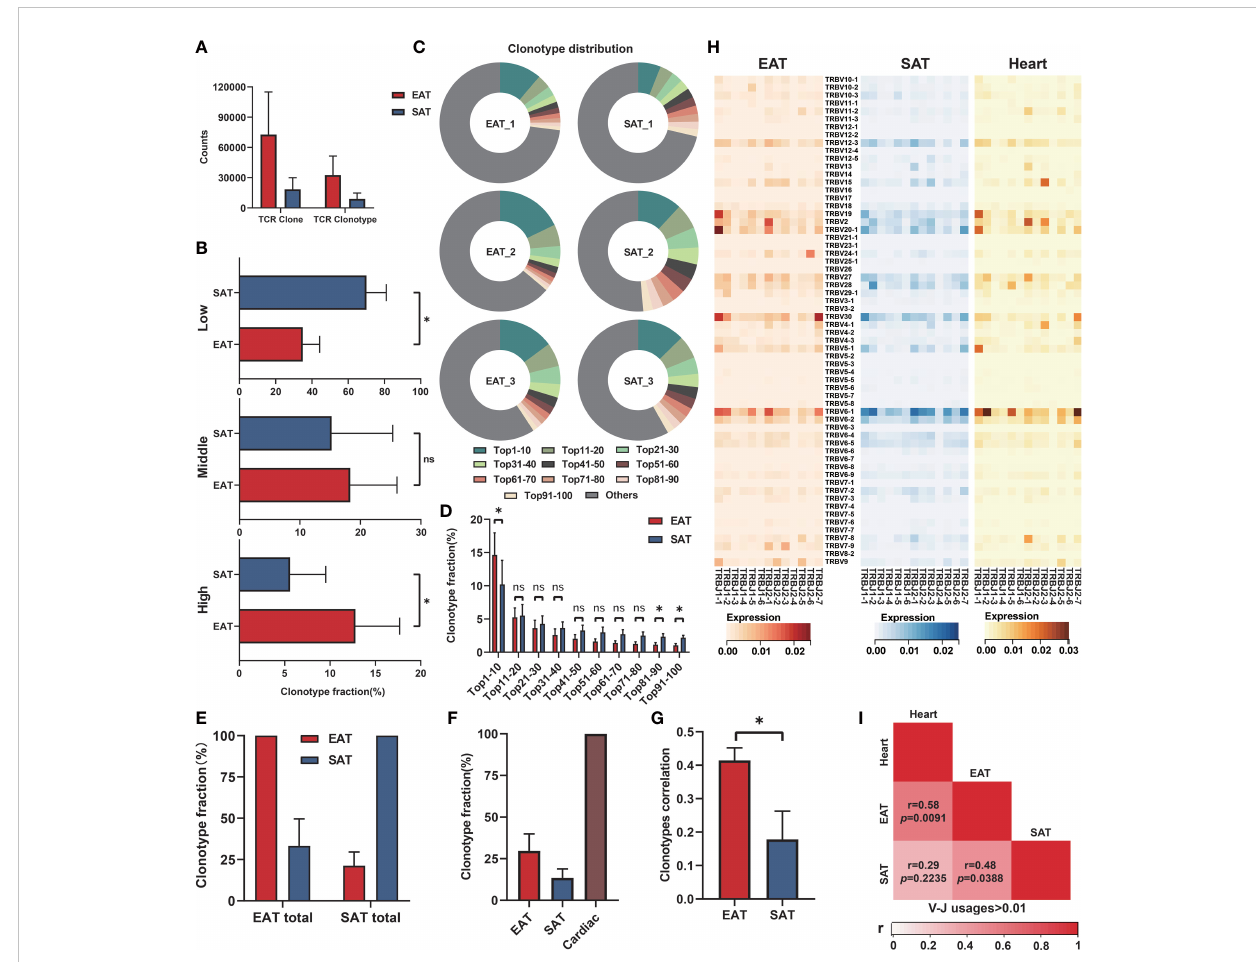
FIGURE 5 Characteristics of TCR repertoires in EAT. (A) TCR clone counts and TCR clonotype counts in EAT and paired SAT. (B) Fraction of low (proportion>0.1%), middle (proportion>0.5%) and high (proportion>1%) frequency TCR clonotypes between EAT and paired SAT. (C, D) The ratio and difference of the top 100 TCR clonotypes in EAT and paired SAT. (E) Total TCR clonotypes sharing between paired EAT and SAT. (F) Total cardiac TCR clonotypes sharing in paired EAT and SAT. (G) Spearman ’ s correlation of cardiac TCR clonotypes with paired EAT and SAT. (H) Heat map of